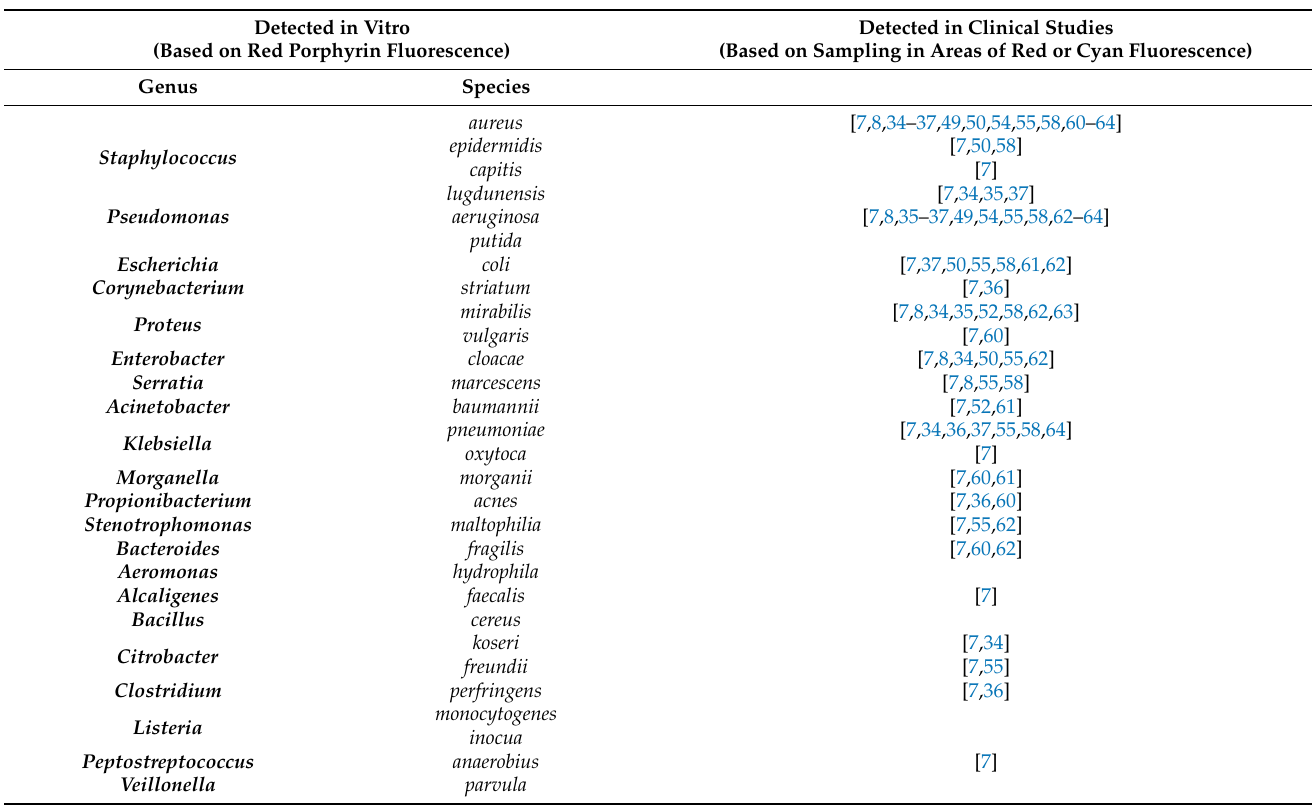
Table 3. Analysis of bacterial species reported in publications that assessed MolecuLight i:X fluorescence imaging. All microbiology samples were taken from wounds exhibiting red or cyan fluorescence. The list of bacterial species represents bacterial species confirmed to produce porphyrin-specific red fluorescence in vitro [56]. Detected in Vitro Detected in Clinical Studies (Based on Red Porphyrin Fluorescence) (Based on Sampling in Areas of Red or Cyan Fluorescence) Genus